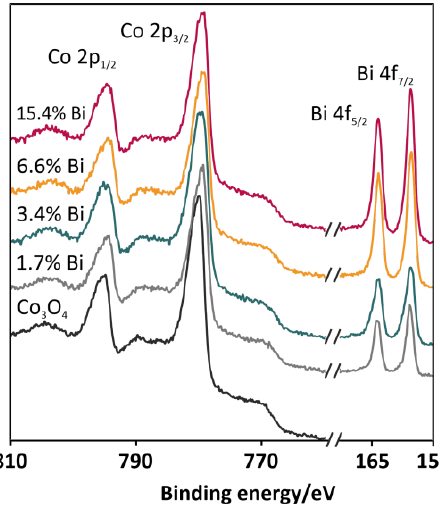
Figure 4. XPS spectra for the selected catalysts (undoped Co 3 O 4 and Co 3 O 4 doped with 1.7, 3.4, 6.6, and 15.4 wt % of Bi) with particular emphasis on the Co 2p and Bi 4f binding energies.